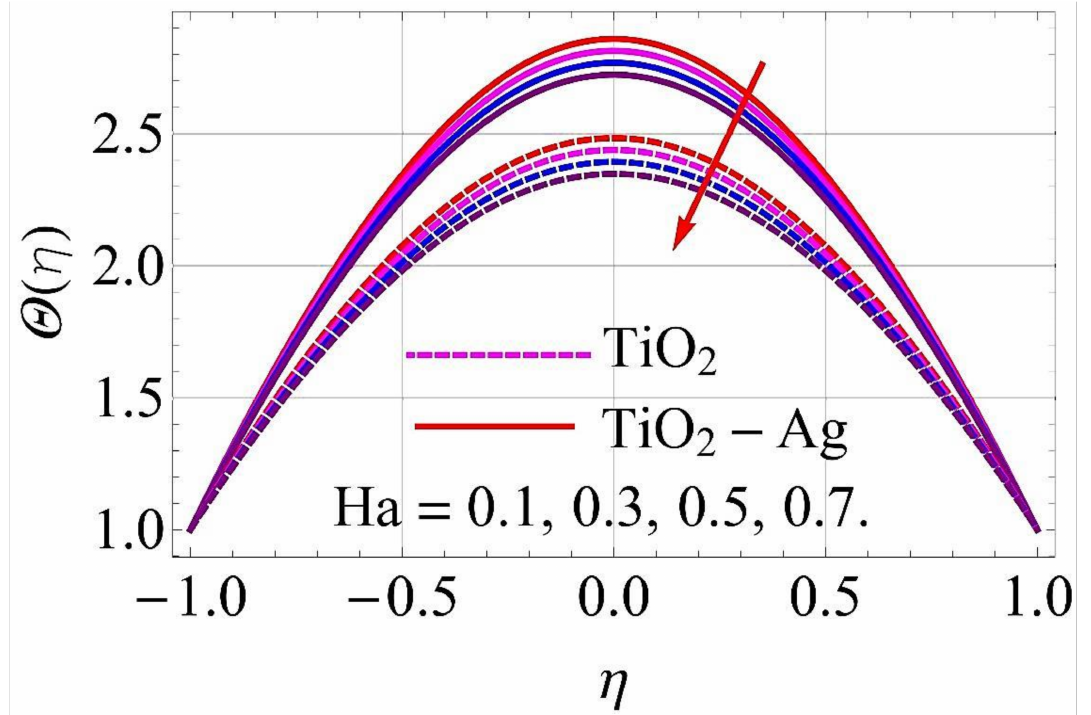
Figure 17. Temperature versus Ha with α = − 5 ◦ for converging/stretching circumstances. When Re = 25, φ 1 = φ 2 = 0.01, Rd = 0.4, Ec = Q = k ∗ = Fr = K 1 = 0.1.